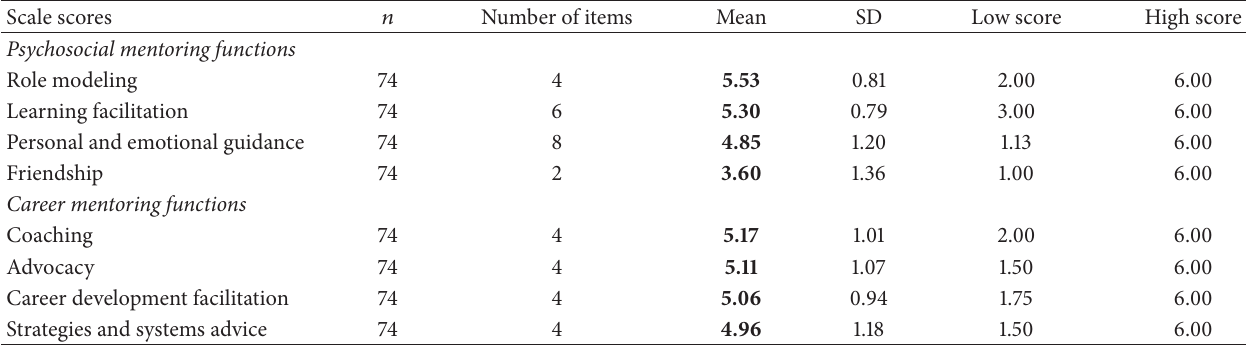
Table 3: Mentoring functions by rank order of mean scores for psychosocial and career subscale (scale range 1 to 6). Scale